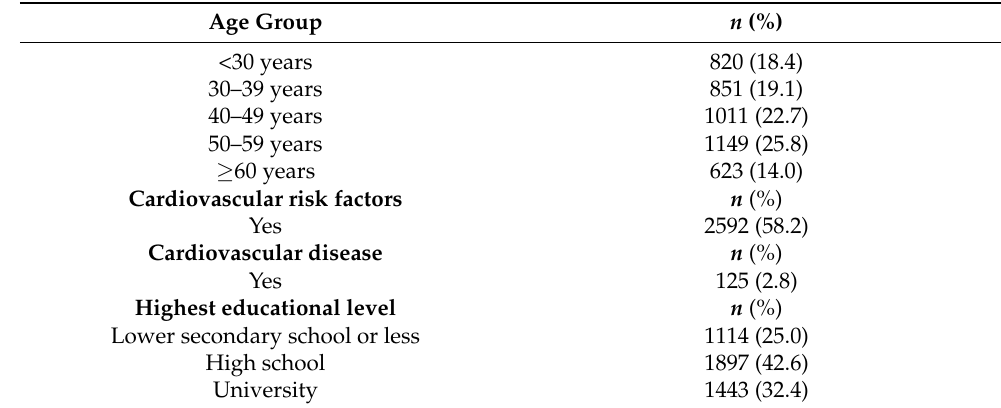
Table 1. Demographics and health characteristics of